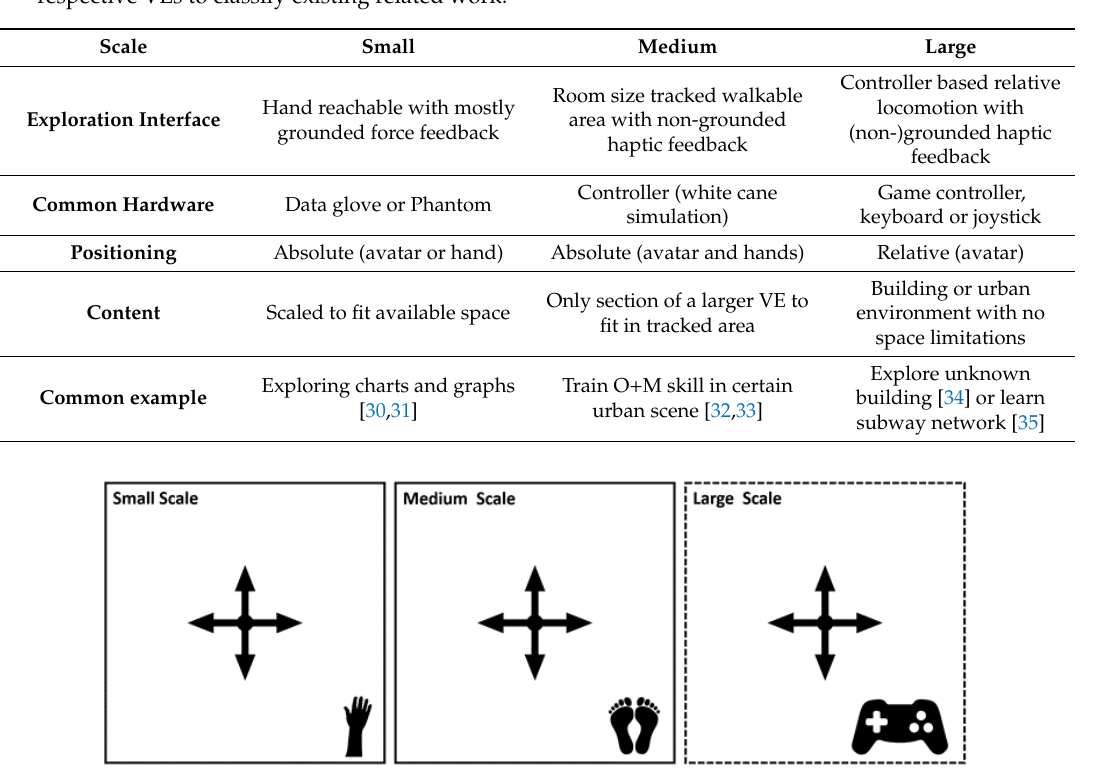
Table 1. Definition and example of small, medium and large-scale according to parameters of the respective VEs to classify existing related work.